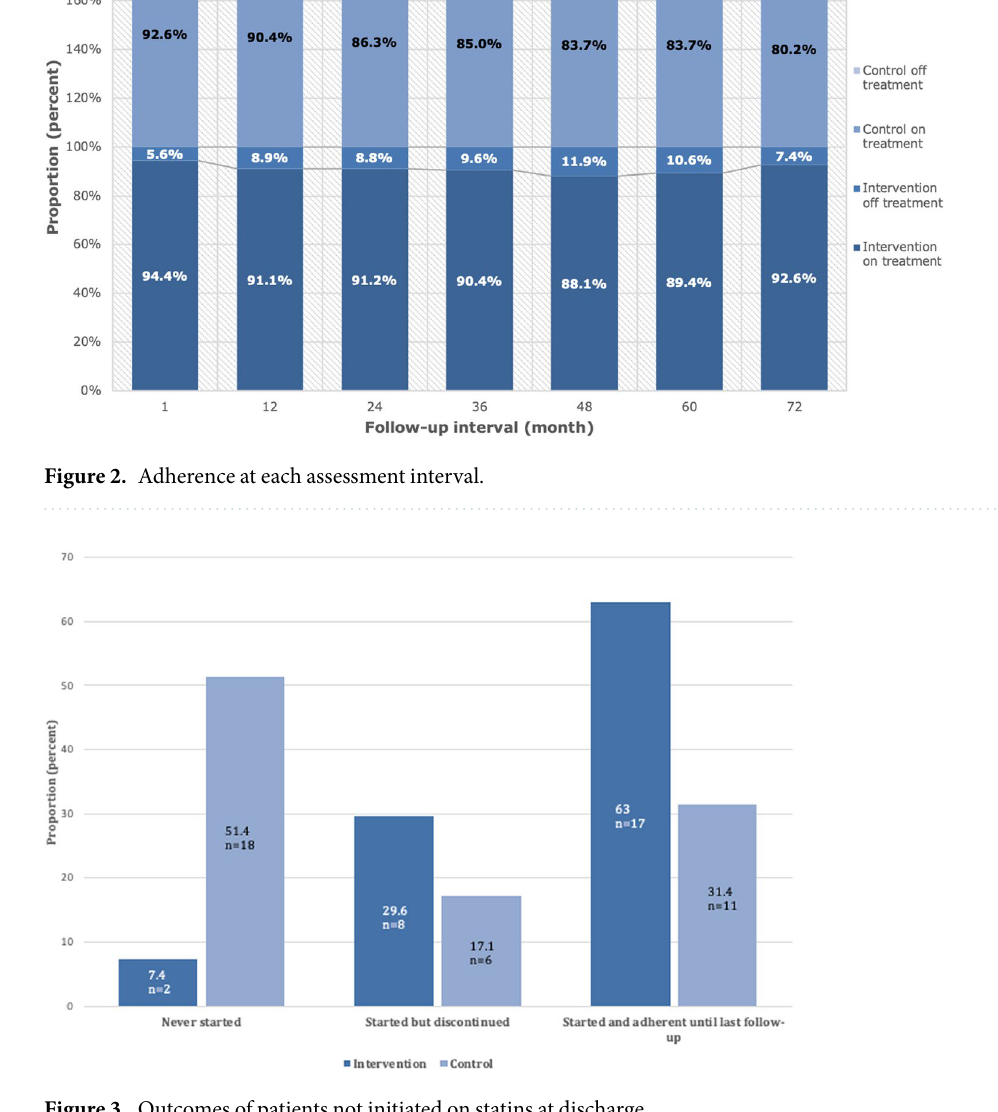
Figure 3. Outcomes of patients not initiated on statins at